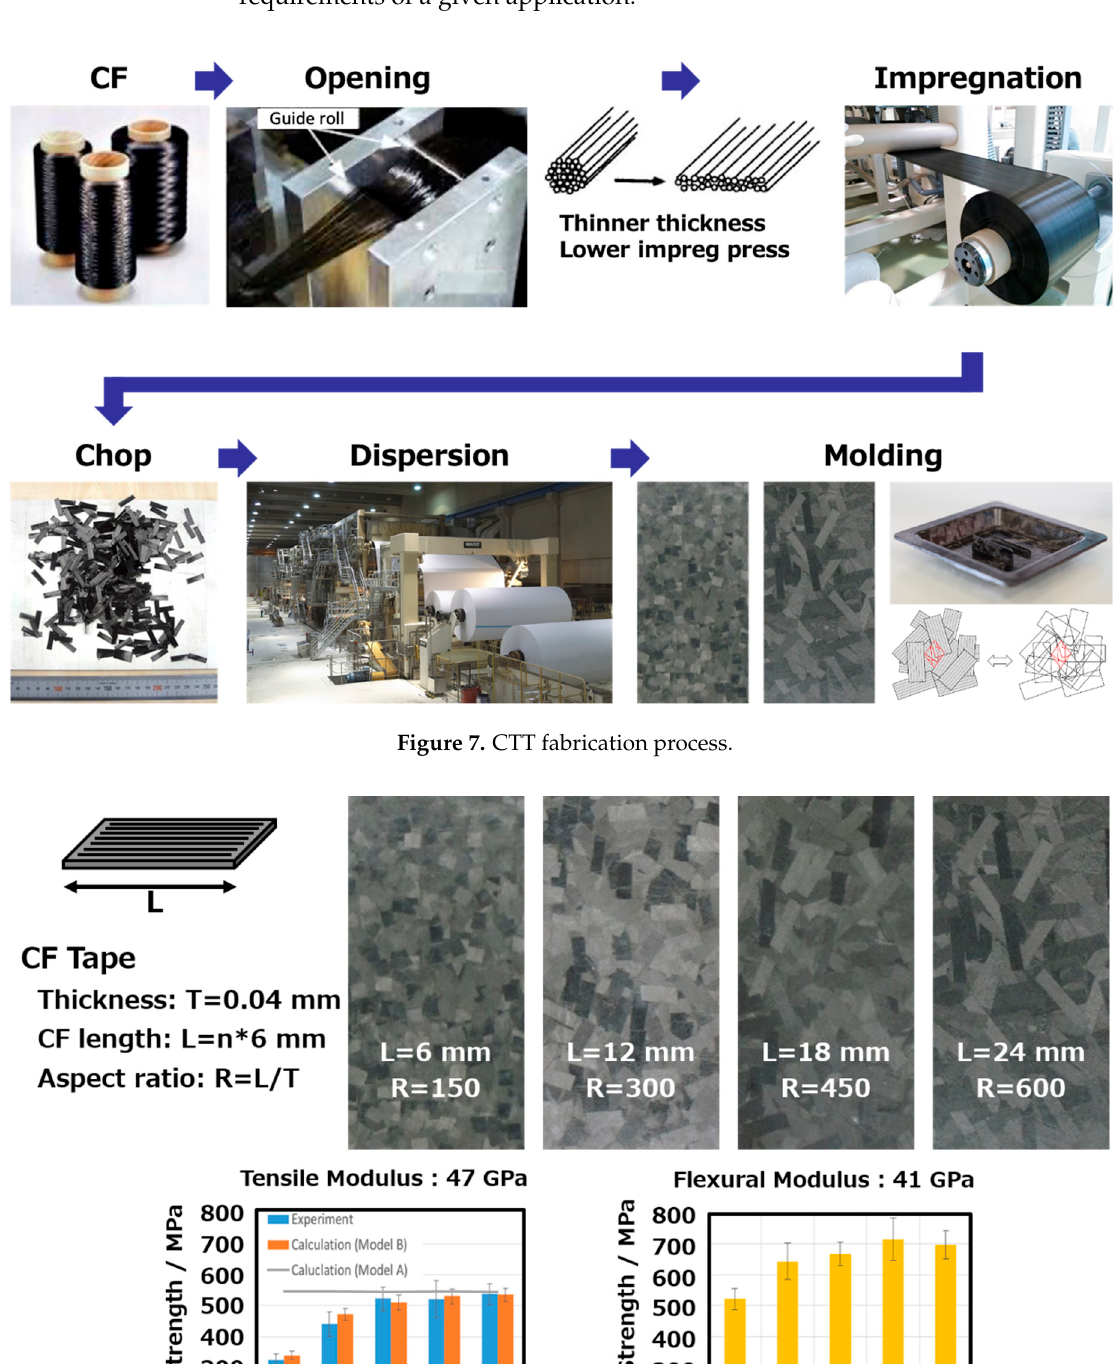
Figure 9. Effects of tape morphology and fabrication process on the mechanical properties of the CTT. Compared to the conventional CFRTSs and discontinuous CFRTPs, CTTs have a re- markable and stable ability to absorb energy. Figure 10 illustrates bolt bearing test results,